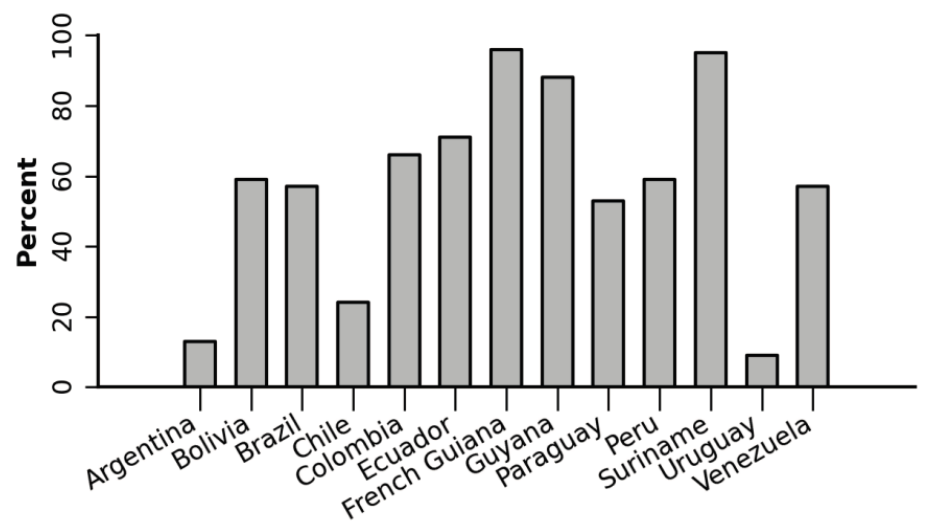
Figure. 6. Percentage distribution of forest areas by country in South